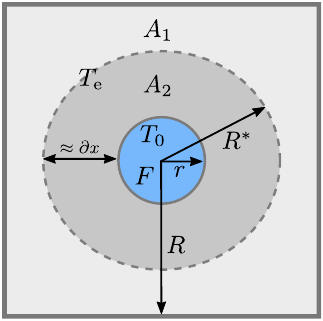
Figure 3. Schematic representation of a preferential flow path with radius r and surface F inside a 1m 2 snowpack (i.e. R = 0 . 5m), seen from above (not to scale), to approximate ∂x . The preferential flow path is assumed to be at melting temperature T 0 , the rest of the snowpack at temperature T e . R ∗ is the radius such that surface areas A 1 and A 2 are equal. When assuming a linear temperature gradient, T e is found at distance R ∗